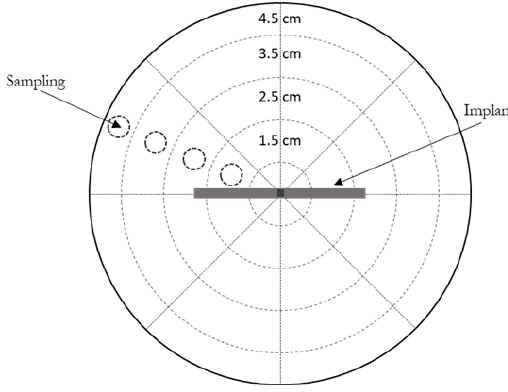
Figure 2. Schematic illustration of the in vitro experimental setup used to sample drug release into agarose gel.